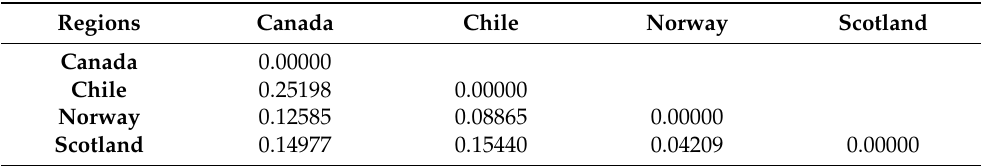
Table 4. The average genetic distances among Saprolegnia spp. calculated by the genetic distance method (Exoffier and Smouse 1994) [23].